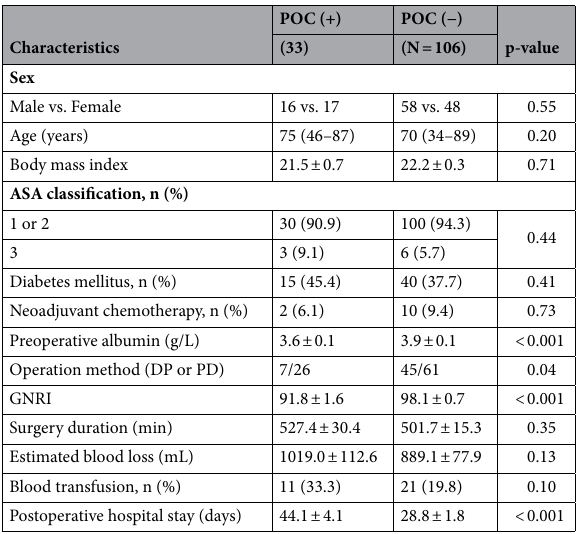
Table 1. Comparison of characteristics of patients with (+) and without (−) postoperative complications. POC, postoperative complications; ASA, American Society of Anesthesiologists; DP, distal pancreatectomy; PD, pancreatoduodenectomy; GNRI, geriatric nutritional risk index.